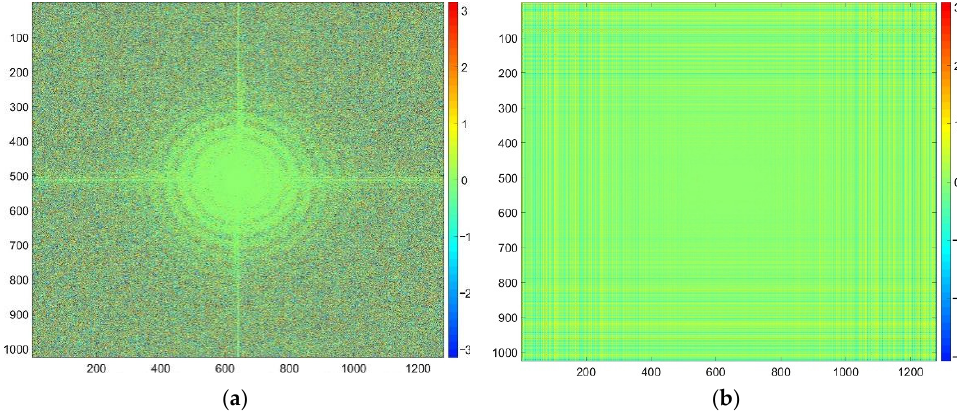
Figure 15. The cross-power spectrum matrix when the displacement is small; where ( a ) is the original cross-power spectrum matrix, ( b ) is the cross-power spectrum matrix restored by using SVD .